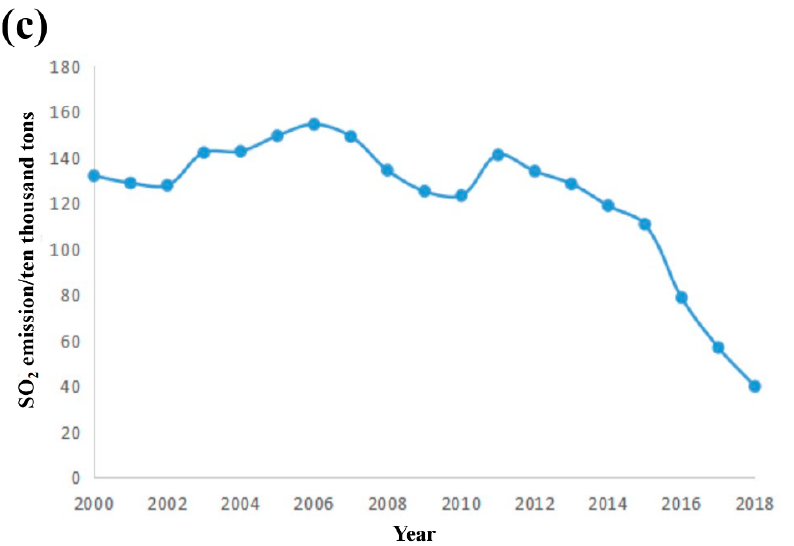
Figure 3. SO 2 ( a ) and dust emission data ( b ) of Beijing and SO 2 emission data of Tianjin and Hebei ( c ).